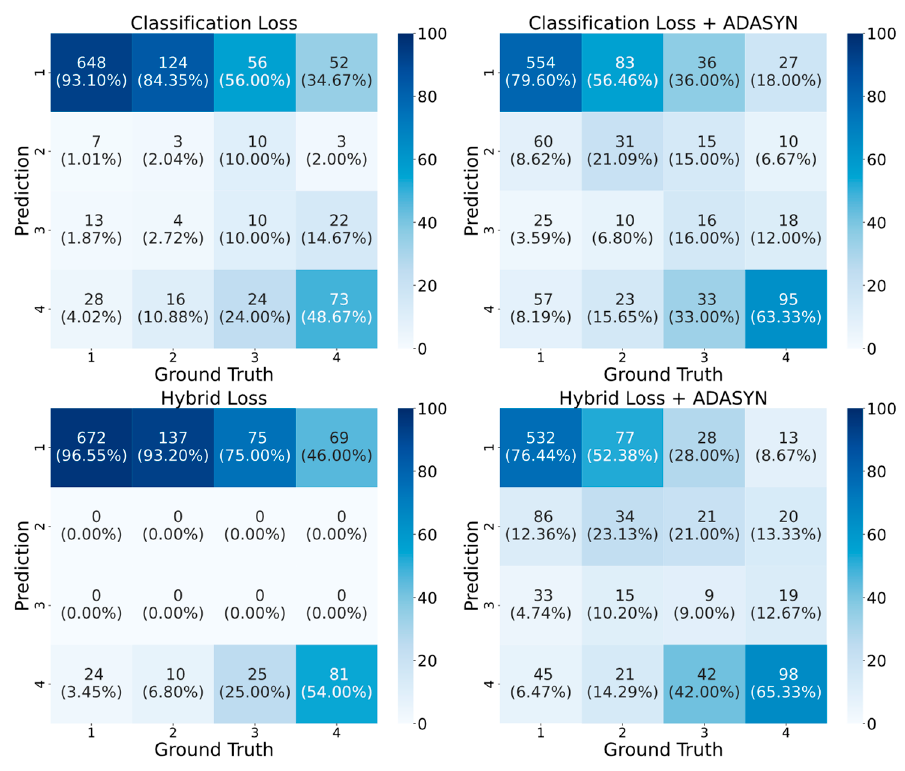
Figure 6. Confusion matrices of HRV models based on the methods in the test dataset.